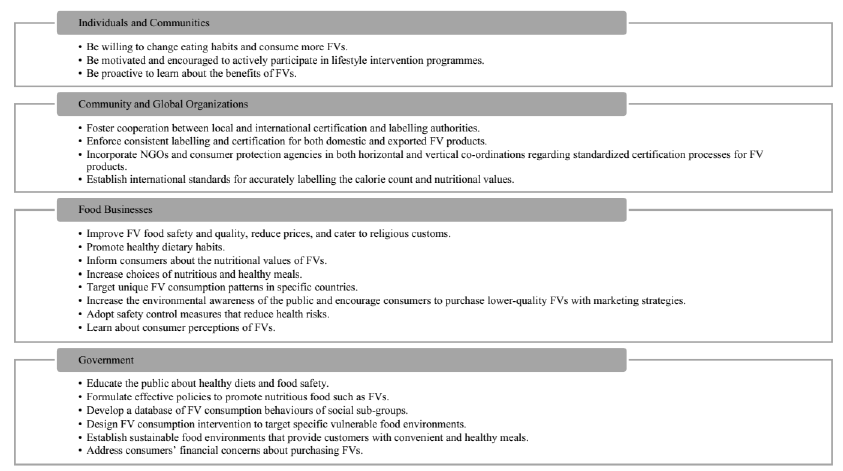
Figure 5. Recommendations for different stakeholders and policymakers to improve FV